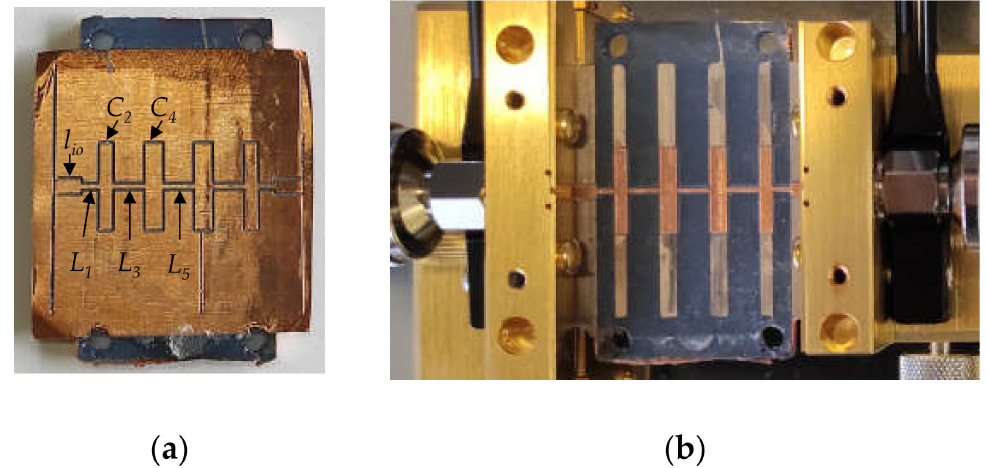
Figure 14. Final implementation of the low pass filter prototype: ( a ) after milling process of the top low and high impedance sections; ( b ) filter characterization using Anritsu 3680 universal test fixture. Table 4. Filter dimensions. High characteristic impedance sections are w = 500 µ m wide, low